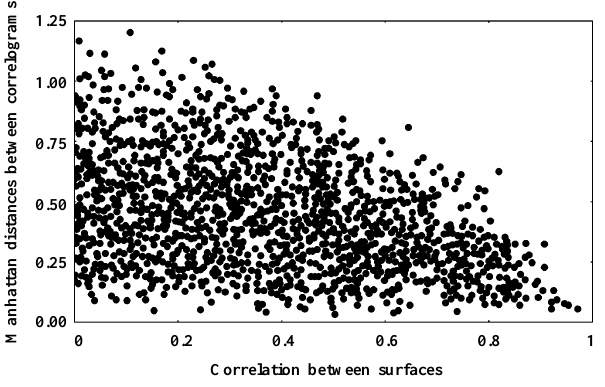
Figure 5 - Relationship between pairwise Manhattan distances between correlograms and correlations between gene frequency surfaces. Note that similar correlograms can be obtained from uncorrelated surfaces.